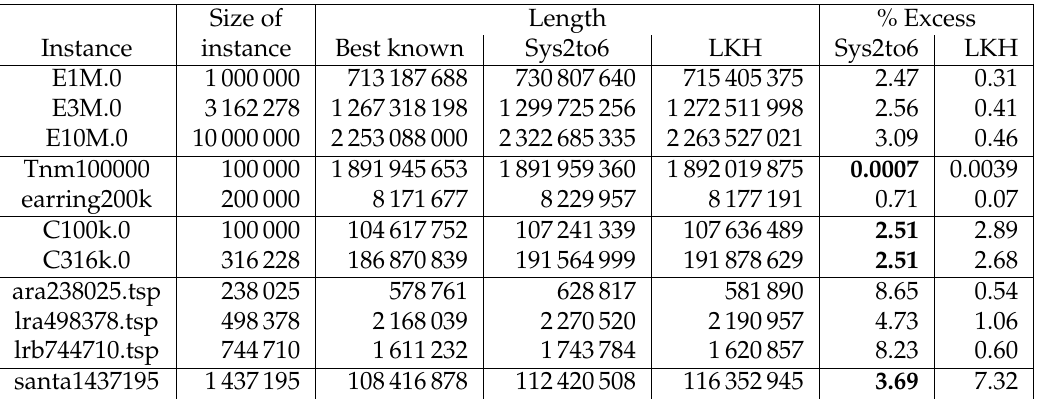
Table 11. Results for different instances after 30 min of processing. Values of column ’Best known length’ are copied from [58] for DIMACS (*.0) and from [59] for VLSI (*.tsp) instances. The best-known results for Tnm100000 and santa1437195 have been reported in [29] and [42], respectively.